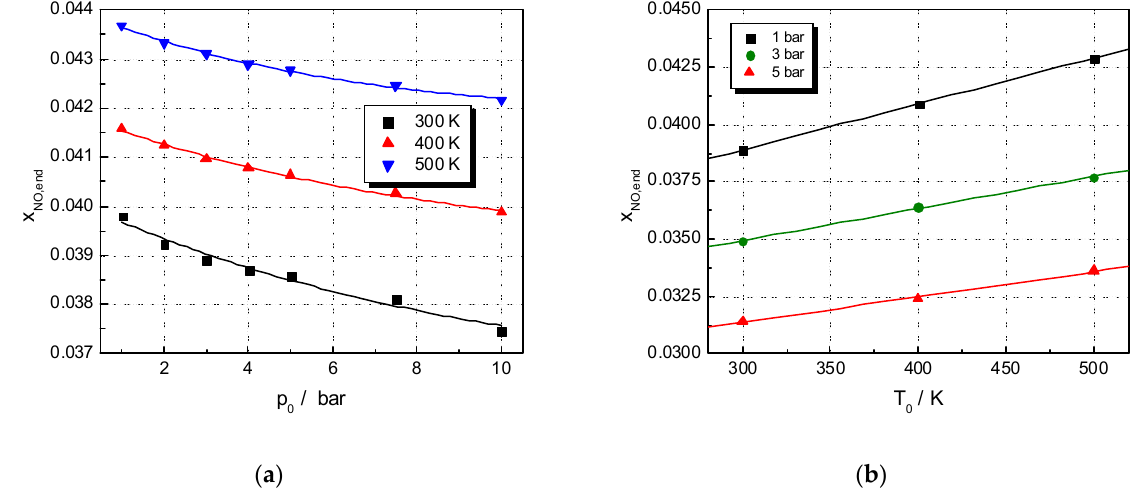
Figure 10. Influence of initial pressure and temperature on NO mass fraction of a stoichiometric H 2 –N 2 O–40%N 2 flame: ( a ) mixtures at a constant initial temperature (T 0 = 300, 400 and 500 K); ( b ) mixtures at a constant initial pressure (p 0 = 1, 3 and 5 bar).